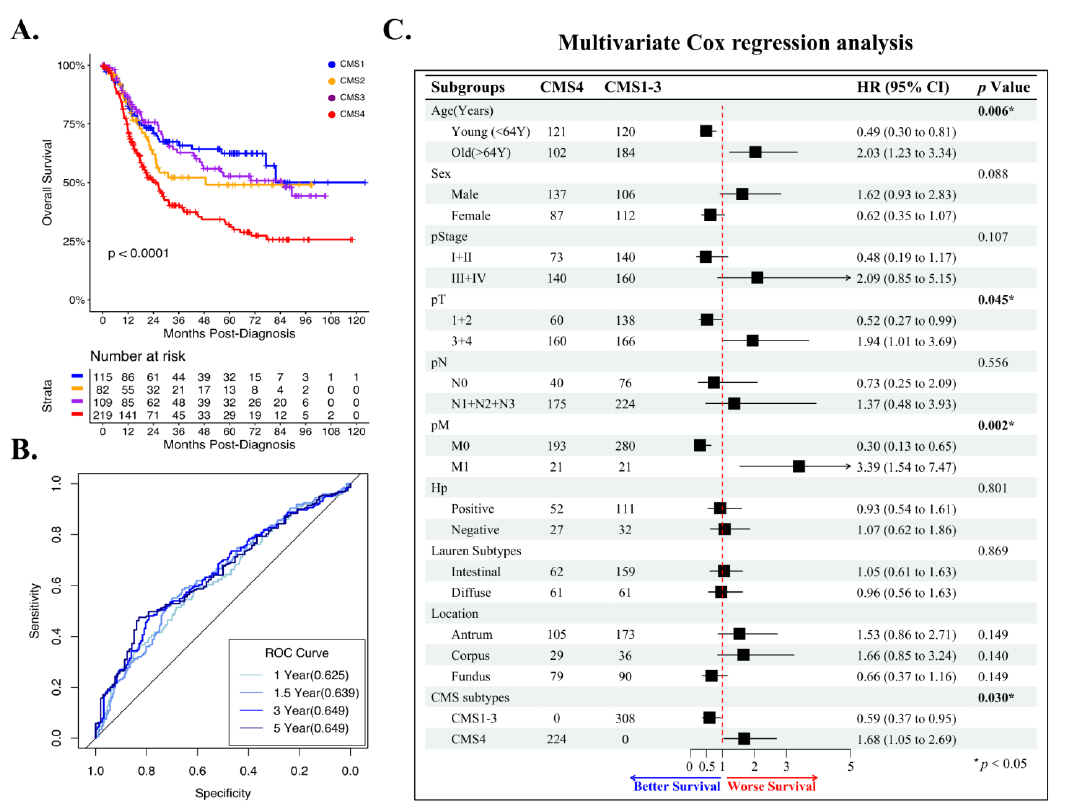
Figure 4. CMS4 is an independent predictor of GAC overall survival. ( A ) CMS4 has the poorest overall survival of any CMS classification in the combined ACRG/STAD dataset, with a median OS of approximately 24.2 months, compared to 48.7 months for CMS2, 85.6 months for CMS3, and >120 months for CMS1 ( p < 0.0001). ( B ) ROC analysis demonstrating moderate sensitivity and specificity for OS in the combined ACRG/STAD dataset at 1, 1.5, 3, and 5 years postdiagnosis (AUC: 0.625 – 0.649, p < 0.0001). ( C ) Multivariate Cox regression analysis demonstrating that CMS4 is an independent prognostic factor for OS in GAC ( p = 0.030).